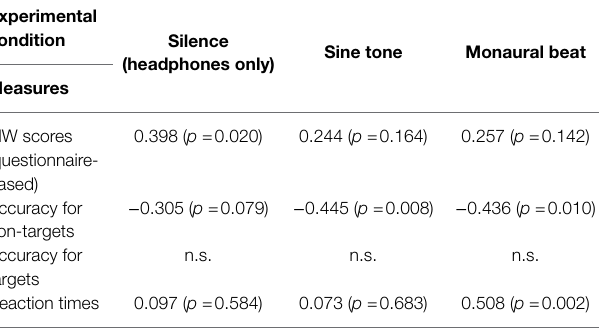
2020) was performed under normal (pre-pandemic) conditions.